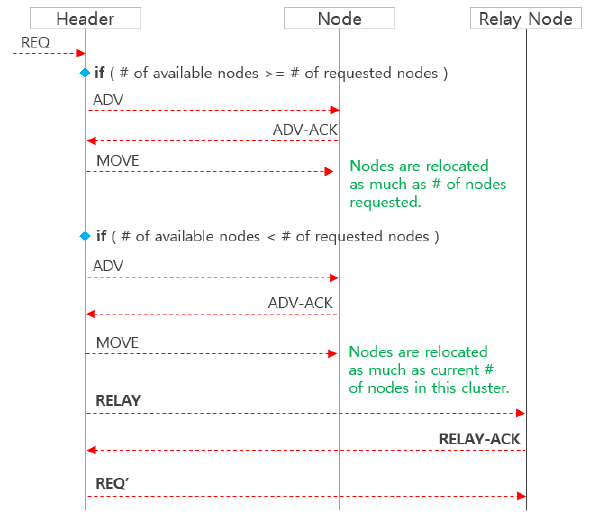
Figure 9. The relocation strategy of a cluster header receiving the REQ message forwarded from Figure 8.